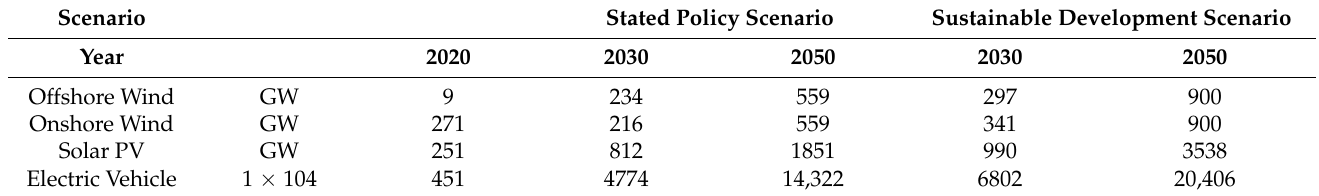
Table 9. Cumulative installed capacity of clean energy generation technologies and electric vehicle stock (Data Source: